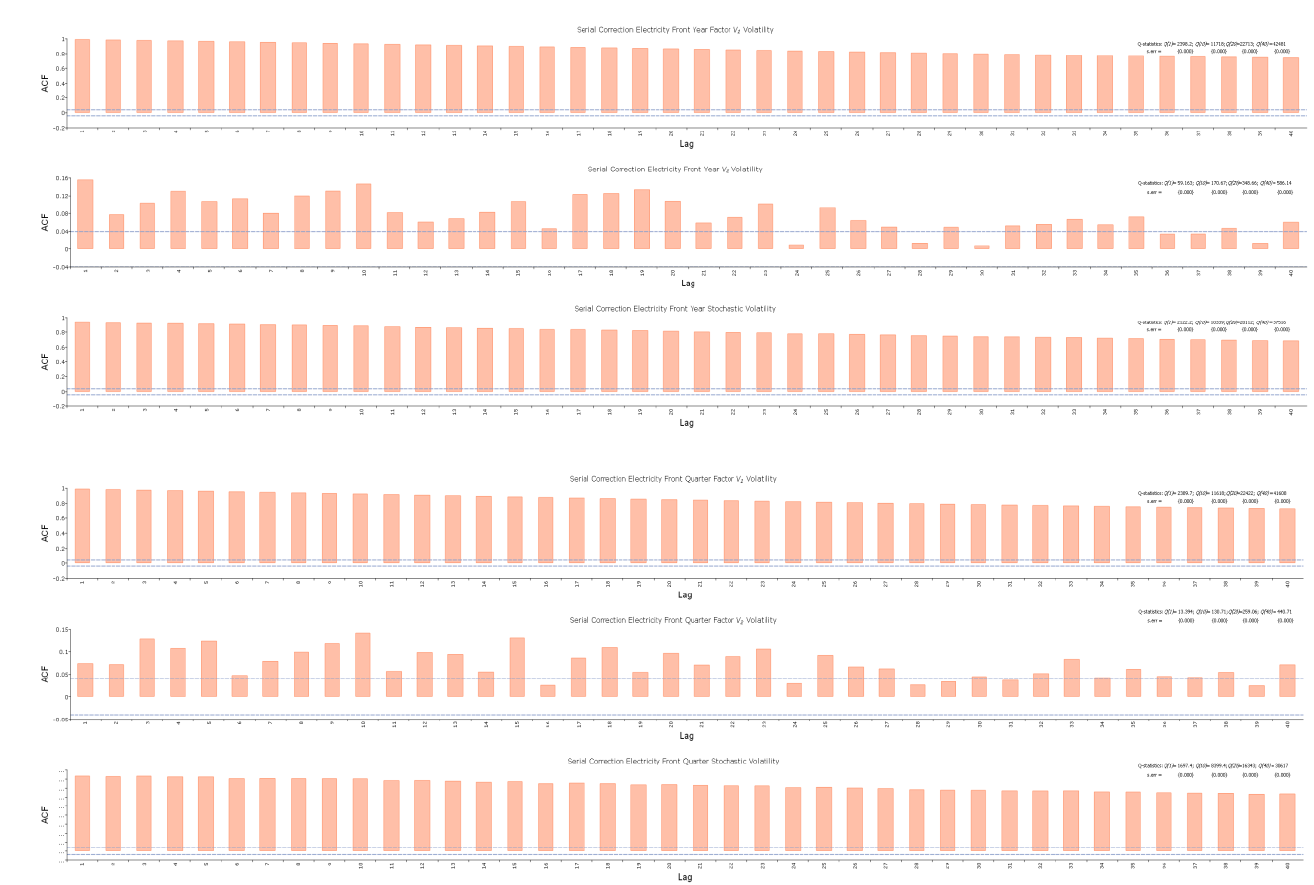
Figure 6. Stochastic Volatility Correlograms from Observables using the Kalman Filter. For the market forecasting, the SV model is estimated for the period 2010–2021 (in-the-sample). The period 2021 to 2022 (4) is the out-of-sample period. Hence, the forecasting period runs from 1 January 2021 to 1 April 2022, with the estimating period for the SV model being from 2010 to 1 January 2021. Note that in practice, the SV model estimation can be estimated every week/month to incorporate the latest information in the model for forecasting purposes. (The SV model does not change significantly during the period 2021 to 2022 (4). For exposition and reporting, the SV model is therefore not updated during the 2021 to 2022 (4) period. In practice, the SV model ’s weekly/monthly update will most certainly be performed for updated information). The RMSE and MAE are scale depend- ent on the dependent variable. The lower the inaccuracy, however, the higher the predict- ing ability. The MAPE and Theil measurements are not affected by scale. Theil ’ s inequality coefficient is 0 for a perfect match. Using the Theil inequality coefficient (bias, variance, and covariance parts), for an “ excellent ” measure of fit, the bias and variance should be modest, with the majority of the bias focusing on the covariance percentage. Table 4 shows static forecast metrics for Nasdaq OMX contracts, and Figure 6 shows forecast plots with 95 percent confidence intervals for both factor components and the annual volatility. These forecasts confirm the benefits of volatility projections giving estimates of validity of using stochastic volatility models. For this application, pricing options are the main ex- ample.